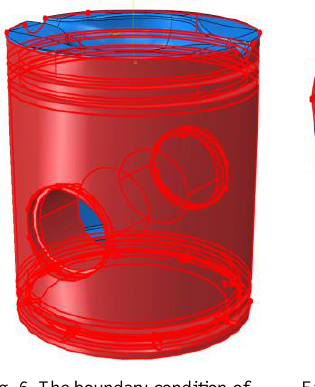
Fig. 6. The boundary condition of Fig. 7. The boundary condition of the piston's thermal load – side the piston thermal load – bottom surfaces – temperature: 393 K, – temperature: 850 K, heat trans- heat transfer coefficient: 500 fer coefficient: map W/(m 2 K) Value of the gap between surfaces [m]